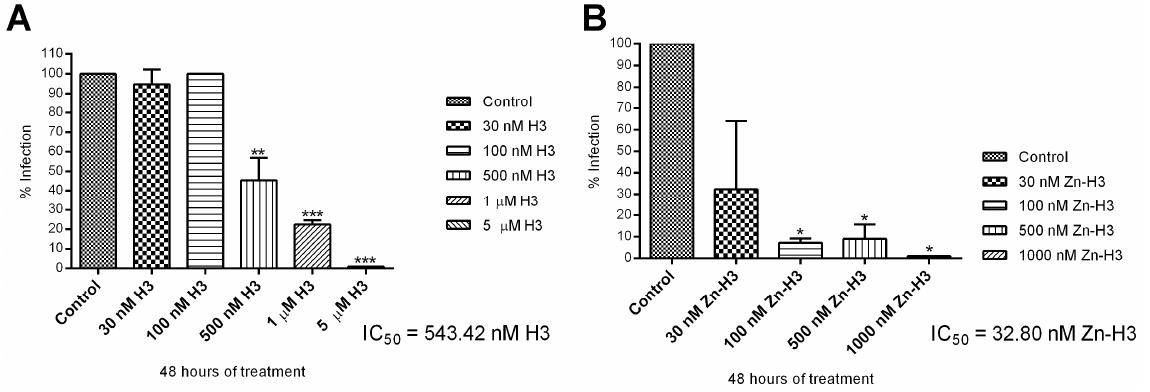
Figure 4. Antiproliferative effects of H3 ( A ) and Zn- H3 ( B ) on Leishmania amazonensis intracellular amastigotes after 48 h of treatment. Macrophages were first infected with metacyclic promastigotes; after 24 h of infection, different concentrations of the compounds were added. At least three experiments were performed; each bar represents the standard deviation. One-way ANOVA with Dunnett’s post hoc test was used for statistical analysis. Asterisks mean different degrees of significance between treated groups and the control. p values: * p < 0.05; ** p < 0.01; *** p < 0.001.